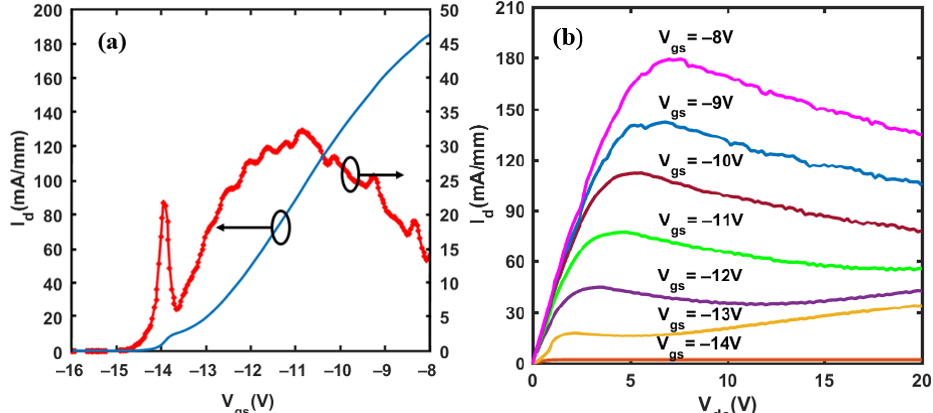
Figure 8. ( a ) The transfer and transconductance characteristics of the fabricated DC GaN HEMT. ( b ) The output characteristics of the fabricated DC GaN HEMT.